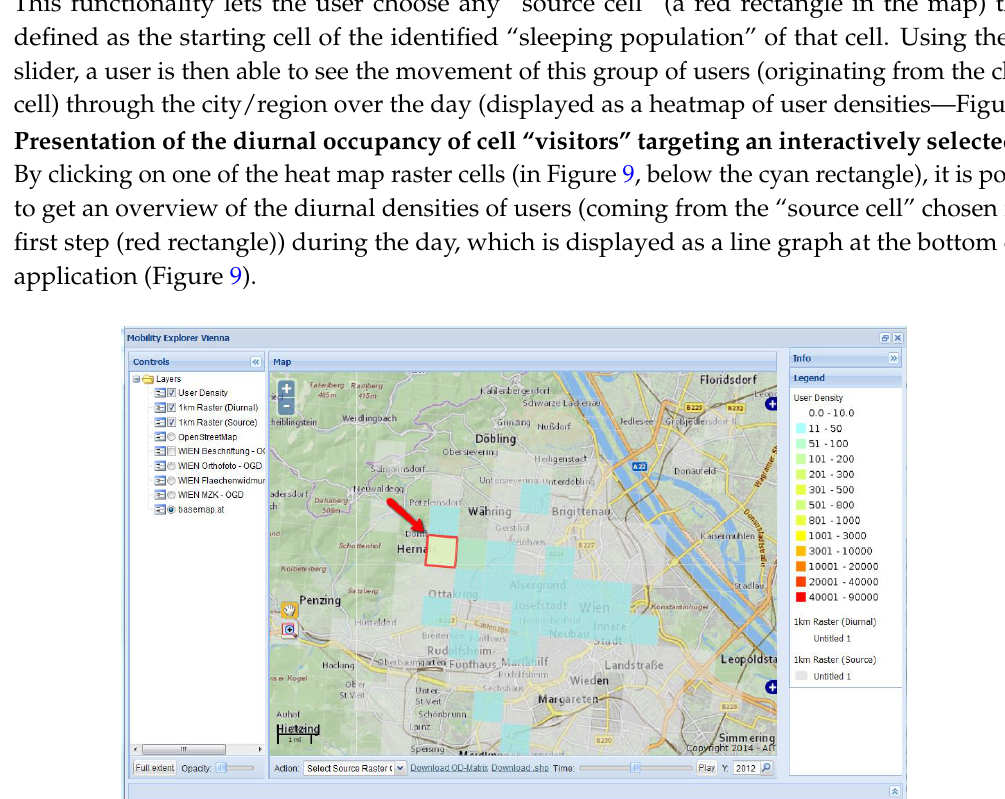
Figure 8. Dynamic mapping of motion dynamics for interactively selected source cell (selected cell marked by bold red outline).